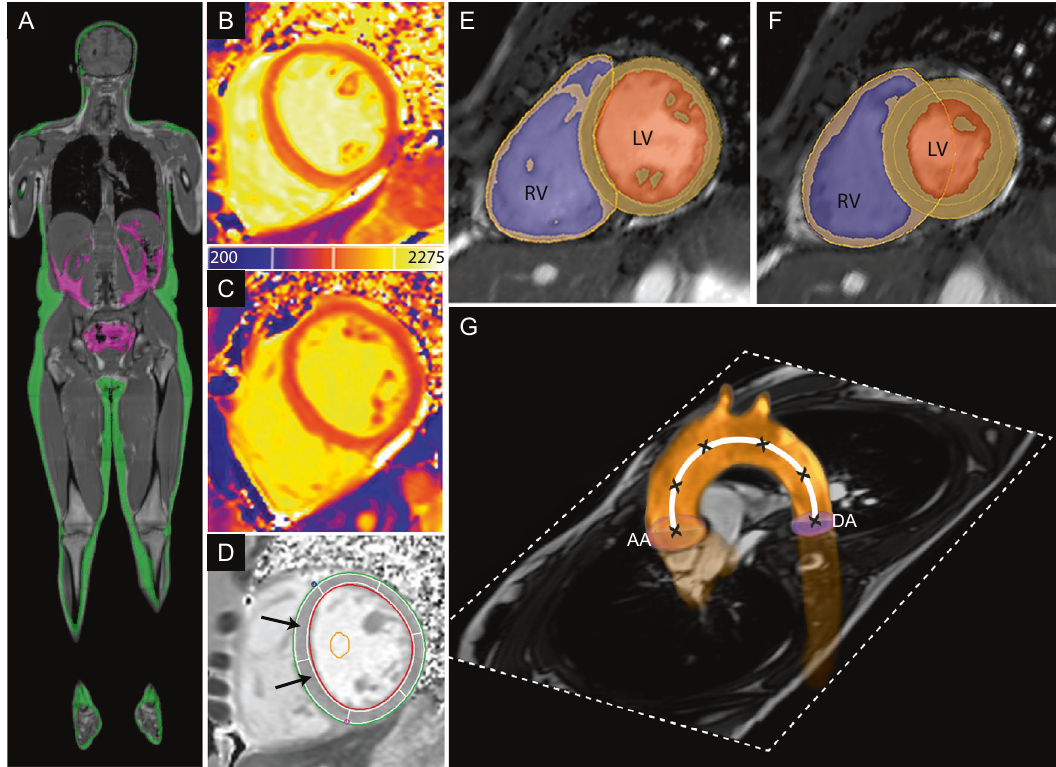
Fig. 2 Magnetic resonance images demonstrating the assessment of cardiac function and mass, native T1, pulse-wave velocity, and whole-body fat. A Whole body fat. Visceral (green) and subcutaneous (purple) adipose tissue segmentations shown on coronal reformat of whole-body fat image. B – D Native T1. Representative native T1 map for healthy control ( B ) and a patient with chronic schizophrenia ( C ). Each slice was semi-automatically segmented with endocardial (red) and epicardial (green) borders and divided into six segments ( D ). Native myocardial T1 time was calculated as the mean T1 time the two septal segments (black arrows). E , F Ventricular function and mass. Endocardial and epicardial contours of the left and right ventricle in diastole ( E ) and systole ( F ). Segmentation shows myocardium (orange), left ventricular (LV) cavity (dark orange), and right ventricular (RV) cavity (purple). G Pulse-wave velocity. Transverse cardiac magnetic resonance imaging slice through the aortic arch displaying the magnitude (dotted white slice) with velocity encoded fl ow through the ascending aorta (AA) and descending aorta (DA). Path length was determined by markers (X) creating a three-dimensional Bezier curve (white line) through the centre of the aorta that intersected the plane at which fl ow measurements were